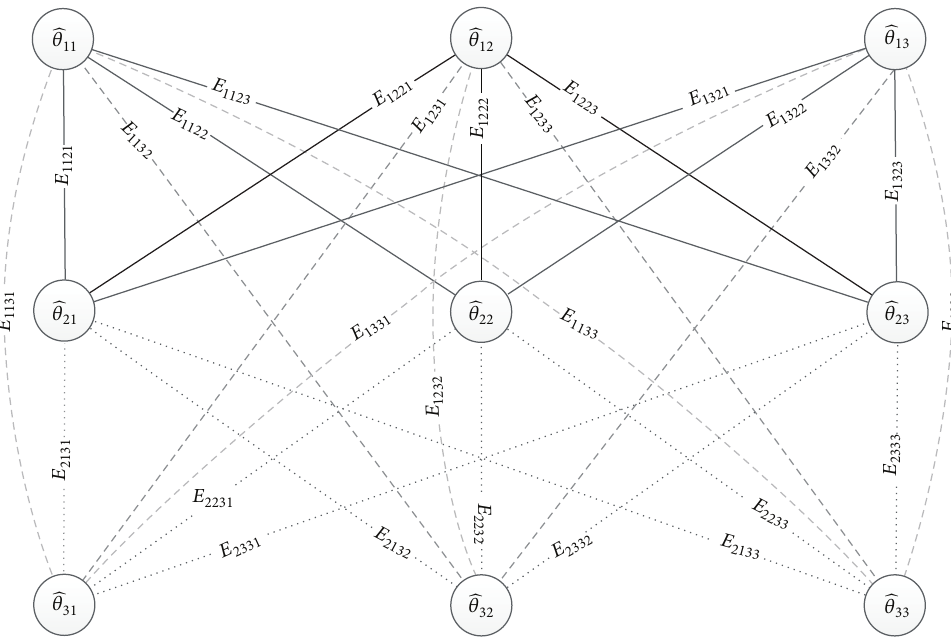
Figure 3: Graphic representation of DOAs and SDs